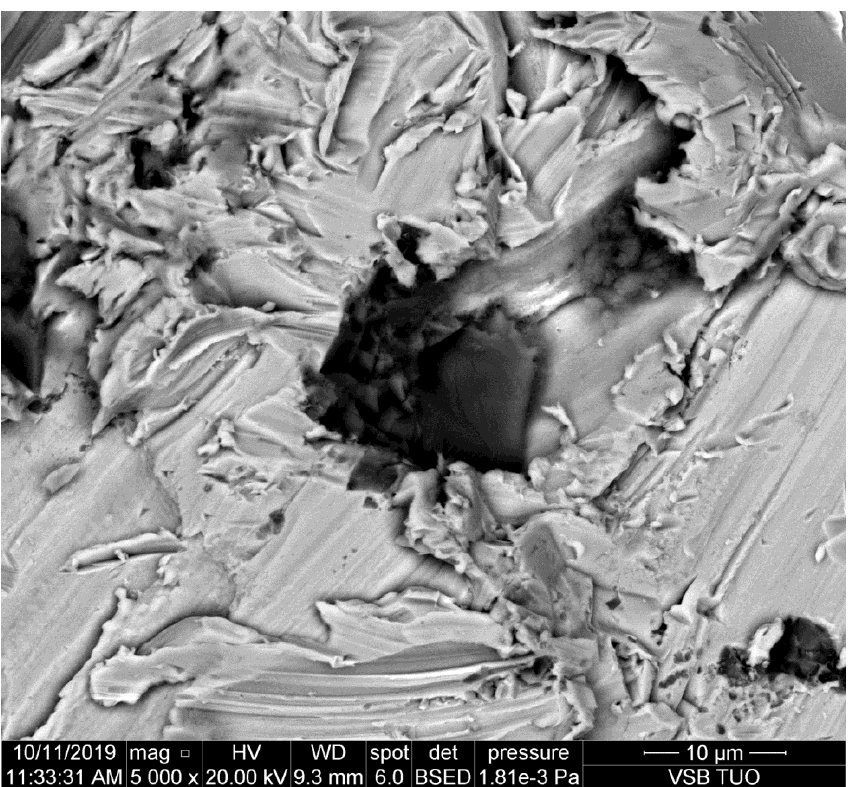
Materials 2021 , 14 , x FOR PEER REVIEW Figure 6. The abrasive particle embossed in the cutting wall of the high strength steel.